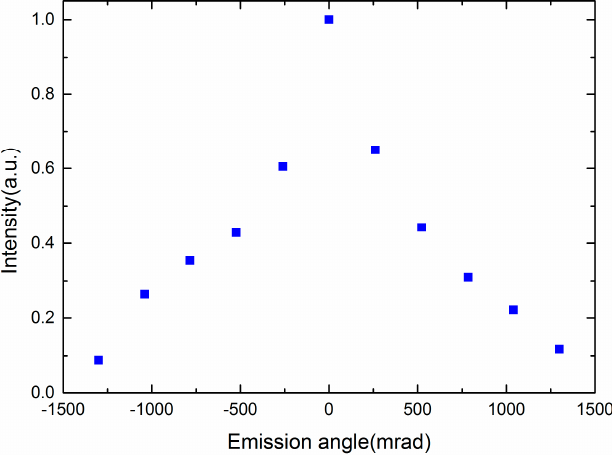
Figure 11. The measured scattering intensity of random lasing.